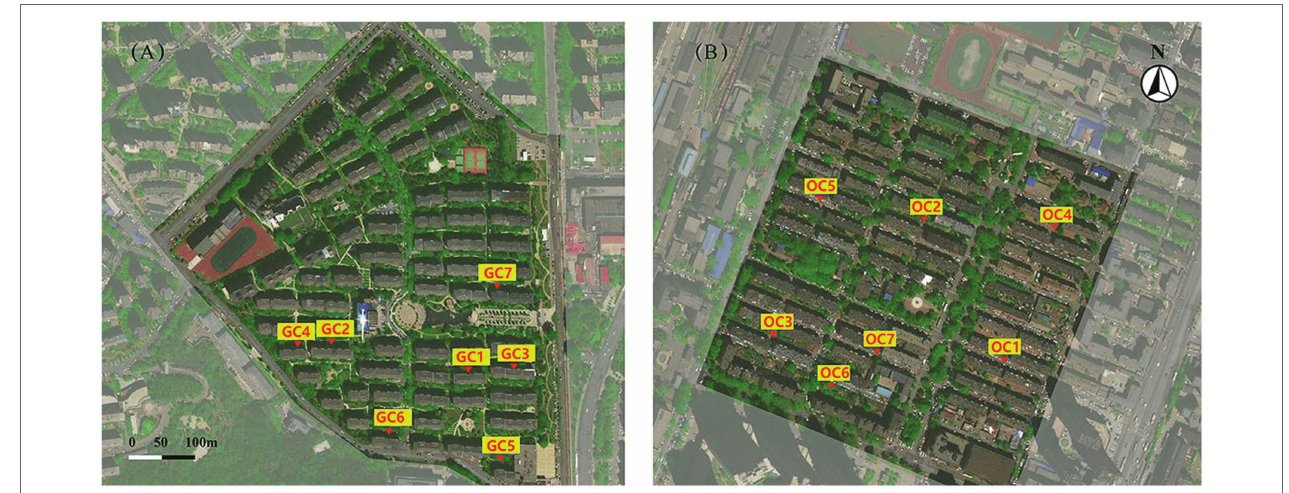
FIGURE 2 | General community planning mode. (A) Xinghai Renjia Community (GC); (B) Xingshe Community